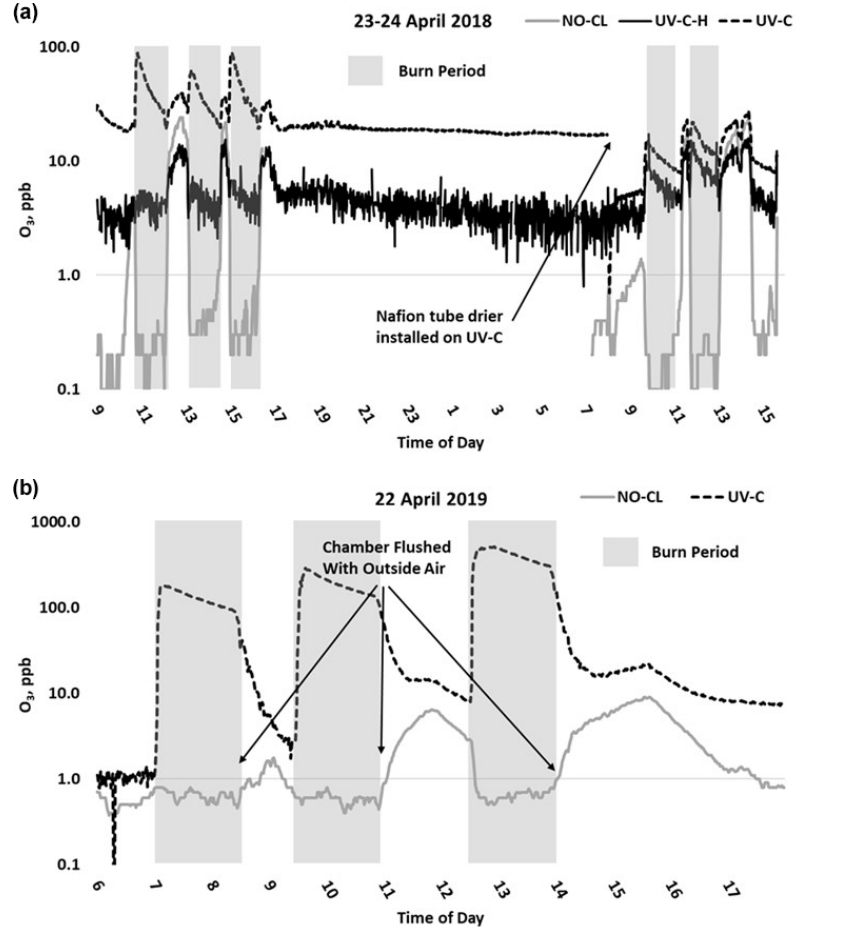
Figure 4. Time series example of USFS chamber burn O 3 results from the NO-CL, UV-C, and UV-C-H (2018 only) from 23–24 April 2018 (a) and 22 April 2019 (b) . O 3 concentrations are displayed on a logarithmic scale. The post-burn calibration checks on 23 April 2018 revealed a + 8% bias in the NO-CL method and a − 2% bias in the UV-C-H method. These biases were evident during the chamber flush periods on that day. Each analyzer was re-zeroed and spanned, resulting in the elimination of the bias between the two methods as observed in the results from the subsequent day (24 April 2018).